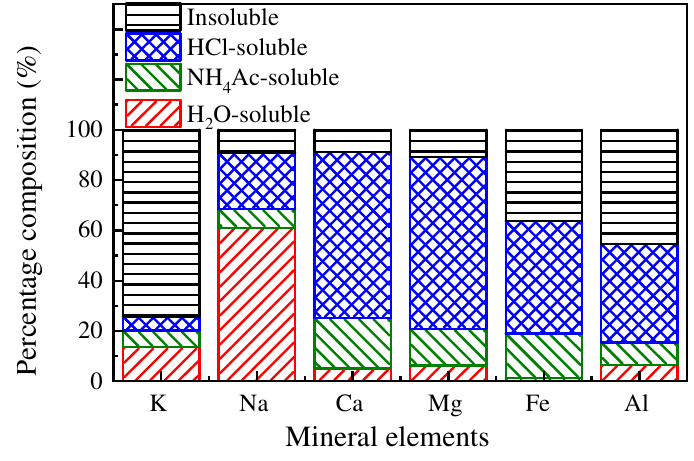
Figure 5. Fractionation of major elements.